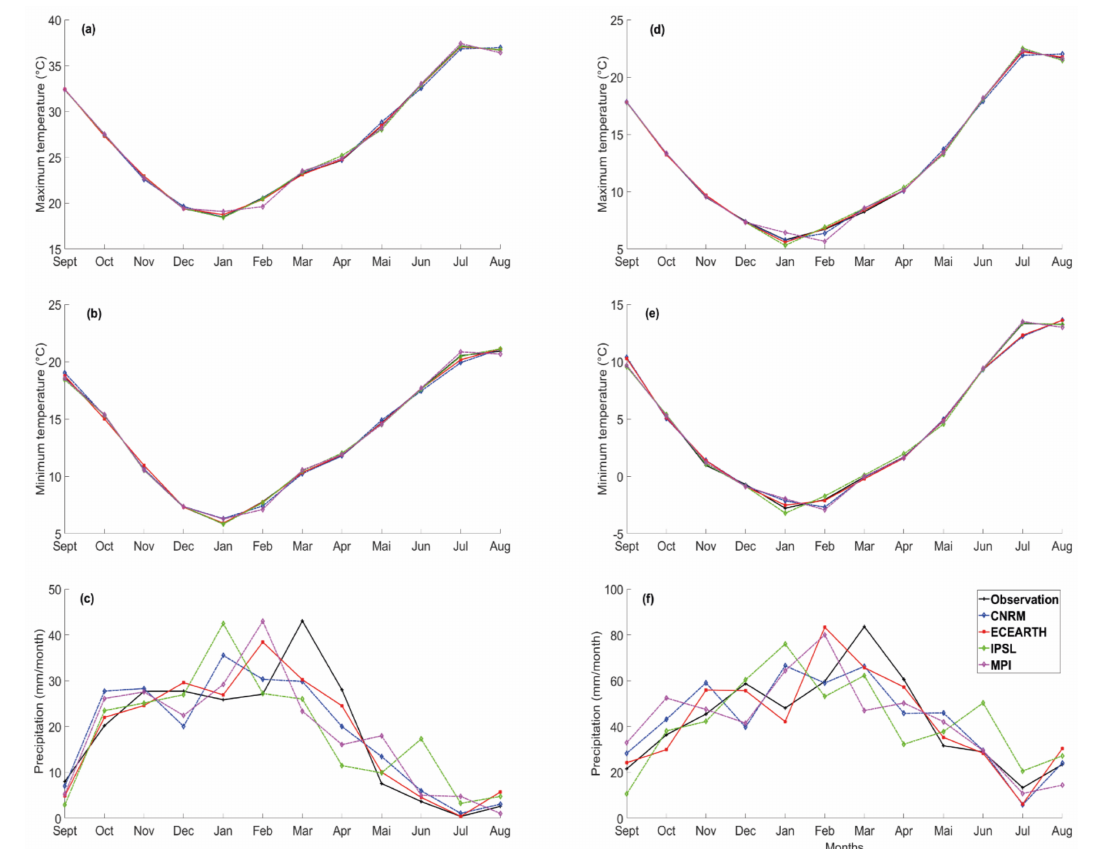
Figure 6. Same as Figure S1 after the application of the quantile–quantile method in the Marrakech ( left ) and Oukaime- den_CAF ( right ) stations for the historical period (1988 to 2005): ( a , d ) maximum air temperature; ( b , e ) minimum air temperature; ( c , f )